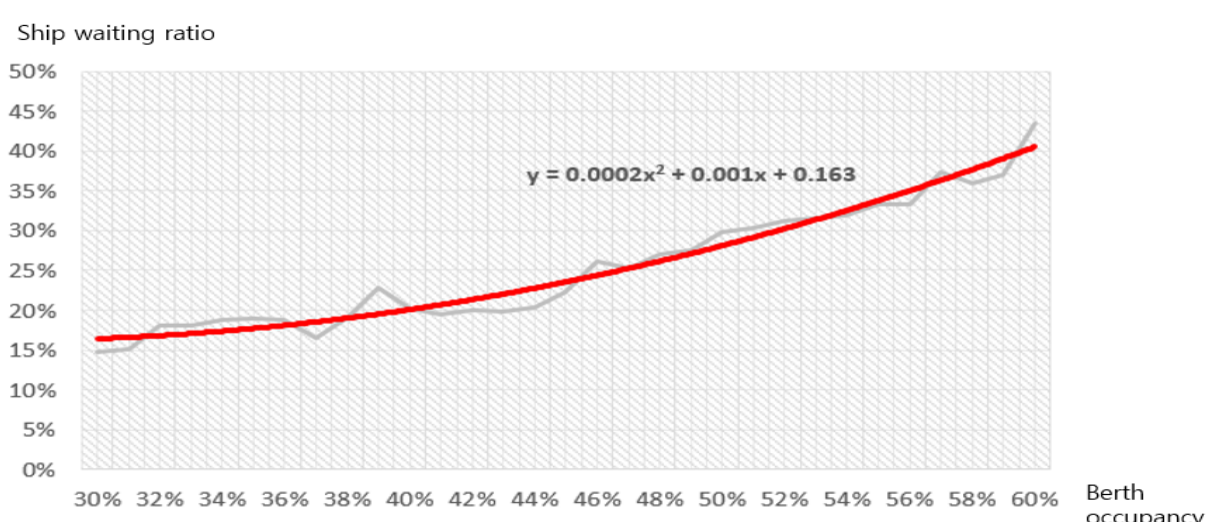
Figure 6. Dolphin occupancy and ship waiting ratio.